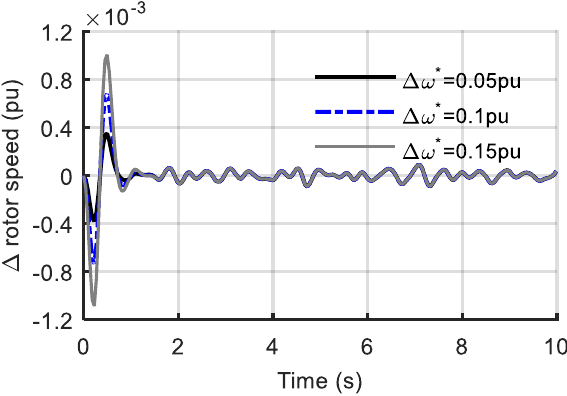
Figure 9. Rotor speed deviations with considering wind speed intermittent nature impact.